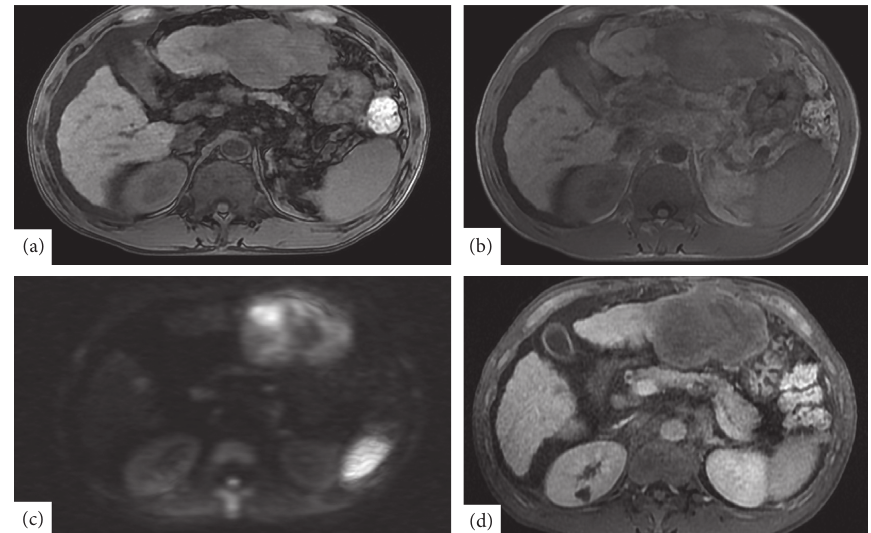
Figure 2: Marked hyperintensity on both the left and right hepatic lobe masses is revealed on diffusion-weighted magnetic resonance imaging (MRI), while peripheral arterial enhancement is seen on gadolinium ethoxybenzyl diethylenetriamine pentaacetic acid-enhanced MRI. (a) T1 in-phase. (b) T1 out-phase. (c) Diffusion-weighted image. (d) Hepatic phase.